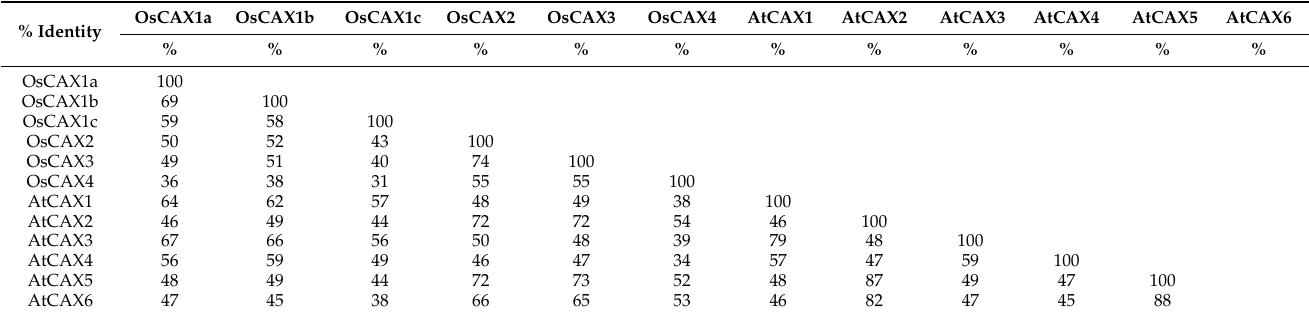
In BLASTP analysis, the identity between the CAX genes is high with a minimum value of 54%, indicating that they are relatively conservative (Figure S2a). The Subfamily IB members have a higher degree of similarities, reaching 71% (Figure S2b), in comparison to the Subfamily IA members, which have their highest identity as 64% (Figure S2c). Sequence identity in aligned regions ranges from 31 to 88% outside of selfhits (Table 2), with the highest percentage of identity being between AtCAX5 and AtCAX6. The lowest identity is between OsCAX1c and OsCAX4 (Table 2). These results indicated that the CAX gene family has high homology in Oryza sativa and Arabidopsis thaliana . Table 2. Percentage of protein sequence identity among the CAX family proteins of Oryza sativa and Arabidopsis thaliana